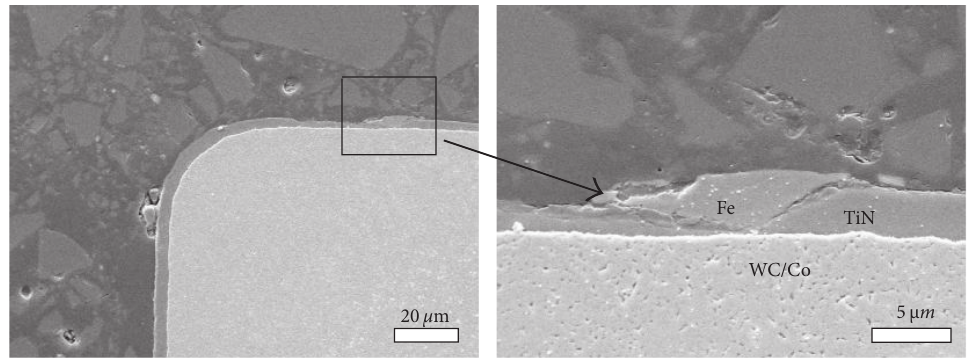
Figure 11: SEM picture of slightly worn TiN-coated cutting tool in final state with cutting parameters as follows: 𝑣 𝑐 = 100 m/min, = 0.1 mm. The cutting edge is shown, and on the right hand side the detail is shown, with a piece of workpiece 𝑓 = 0.5 mm/rev, and 𝑎 𝑝 material adhering to the WC/Co substrate.